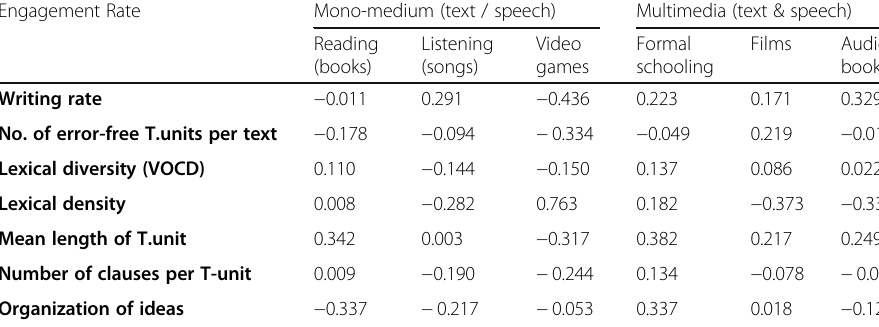
Table 4 Pearson ’ s correlation coefficient: Engagement Rate (Offline learning) Engagement Rate